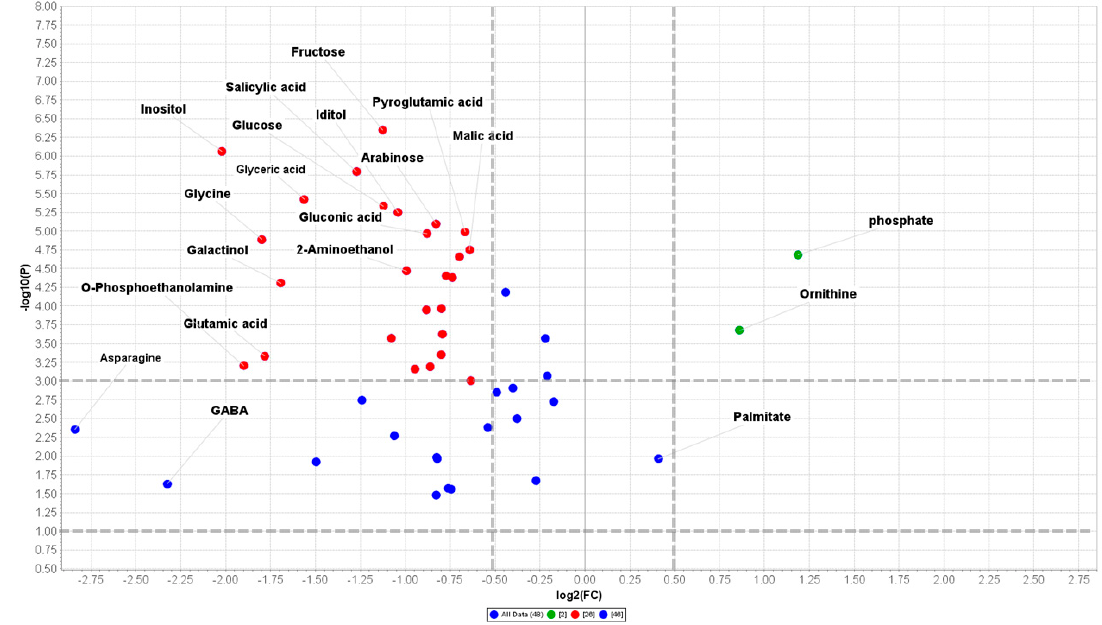
Figure 5. Volcano plot (FC = 1 and p value = 0.05) built on the metabolites annotated in 14 d nerolidol-treated roots of Arabidopsis thaliana . Full data are reported in Table 1 and Table S2. ( n = 3).